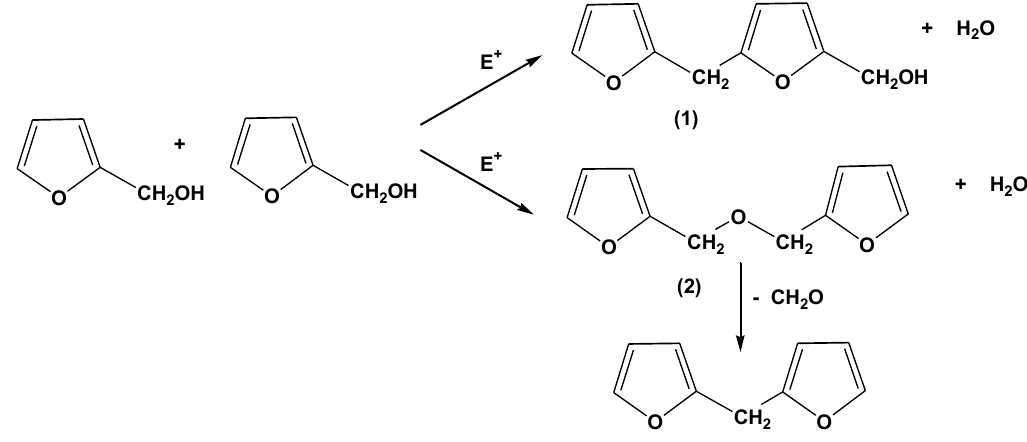
Scheme 2. Reactions proposed for the polymerization and chain extension of furfuryl alcohol resins in the presence of acids and other electrophiles (adapted from